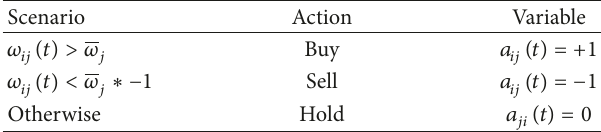
Table 1: Agent decision